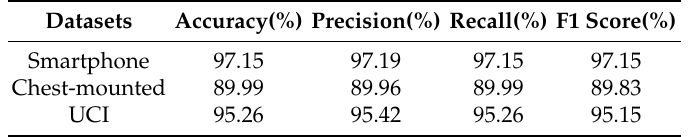
Table 10. Activity recognition performance of SDAE model on other public